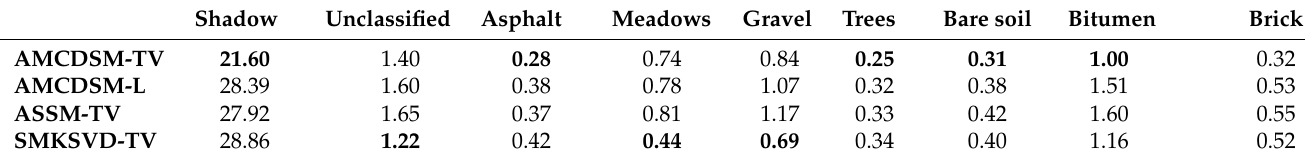
Table 7. Pavia university hyperspectral image: Commission errors of the different